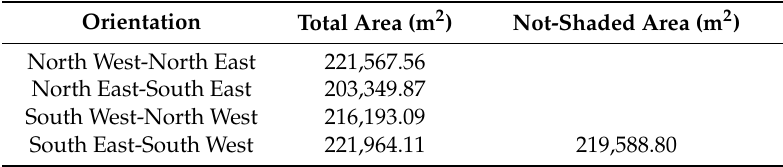
Figure 8. Roof classification, city of Santiago de Compostela. ( a ) All the points classified as roofs are highlighted in red. ( b ) The roofs are colored according to their orientation. Table 5. Measured areas of the roofs according to their orientation, and not-shaded areas (on 7th July, 3 p.m.) only measured on roofs which are oriented to the South east—South west.